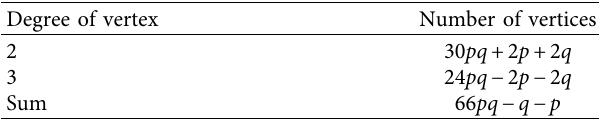
Table 2: Partition of graph G ∗ on the basis of degrees. Degree of